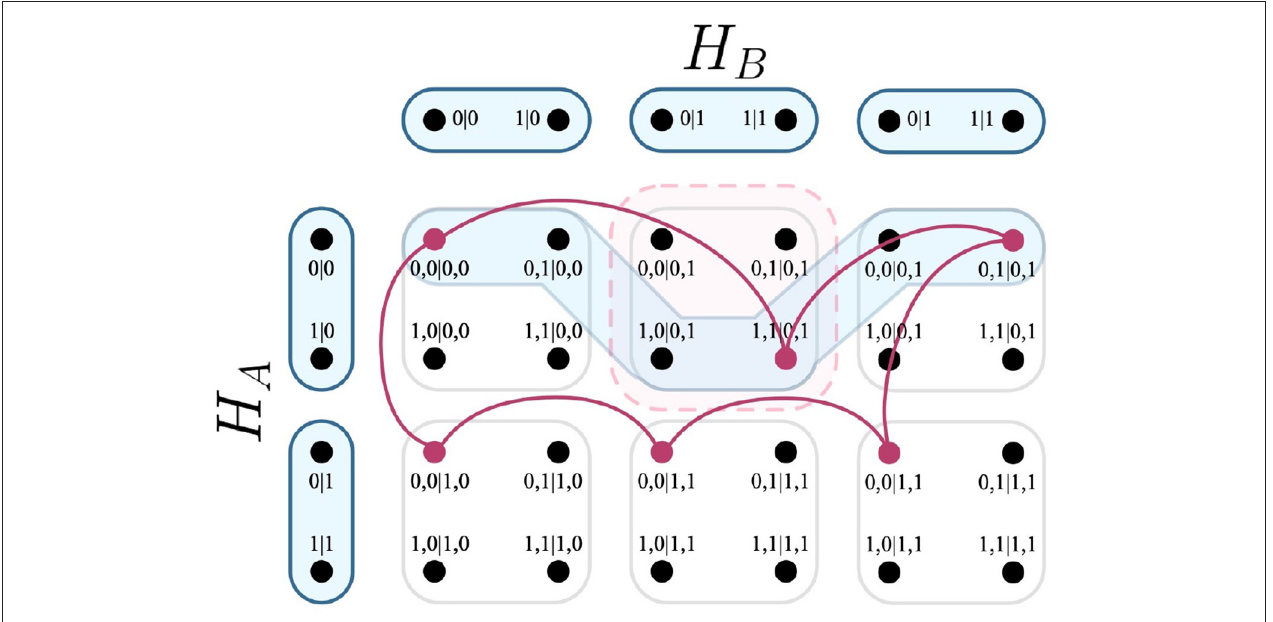
FIGURE 8 | Intersection of a relation, an edges of the F-R product, and a clique within a system that contains three measurements. As shown above, the clique intersects the edge of the F-R product thrice, which evaluates the expression |{ c ∩ e }| − 1 to the value + 2.